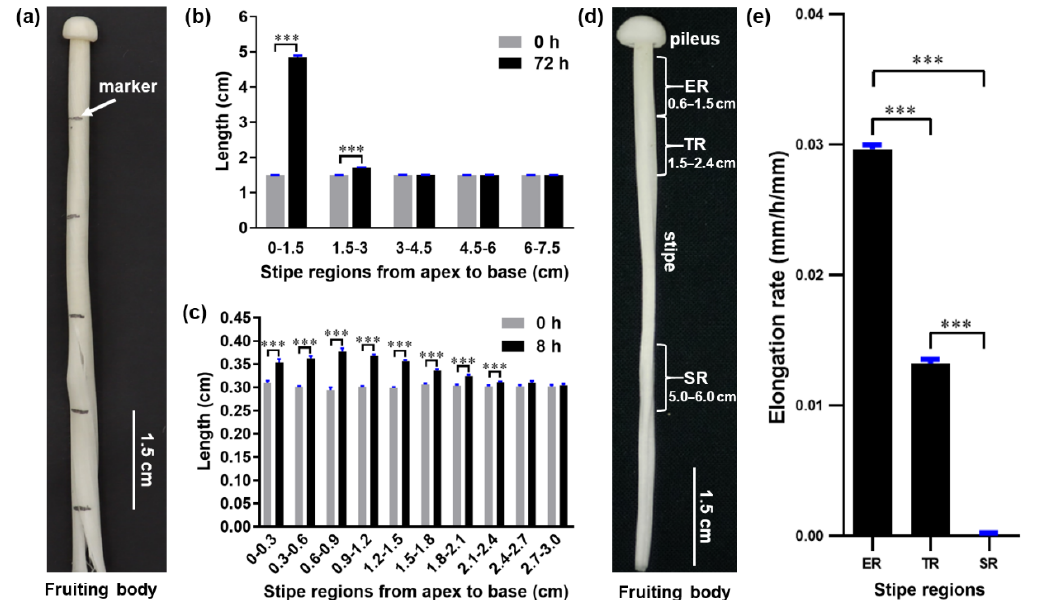
Figure 1. The distribution of elongation along the length of the F. filiformis stipe. ( a ) Marking of the stipe. ( b ) Length of different stipe regions after 72 h growth ( t -test, *** p < 0.001, n = 50). ( c ) Stipe elongation characteristics of the apical 3-cm stipe regions ( t -test, *** p < 0.001, n = 20). ( d ) Different stipe regions: ER, elongation region; TR, transition region; SR, stable region. ( e ) Elongation rates of different stipe regions over 12 h of growth (Tukey’s multiple comparisons test, *** p < 0.001, n = 20). To more precisely determine the main elongating region within the apical 0–1.5 cm